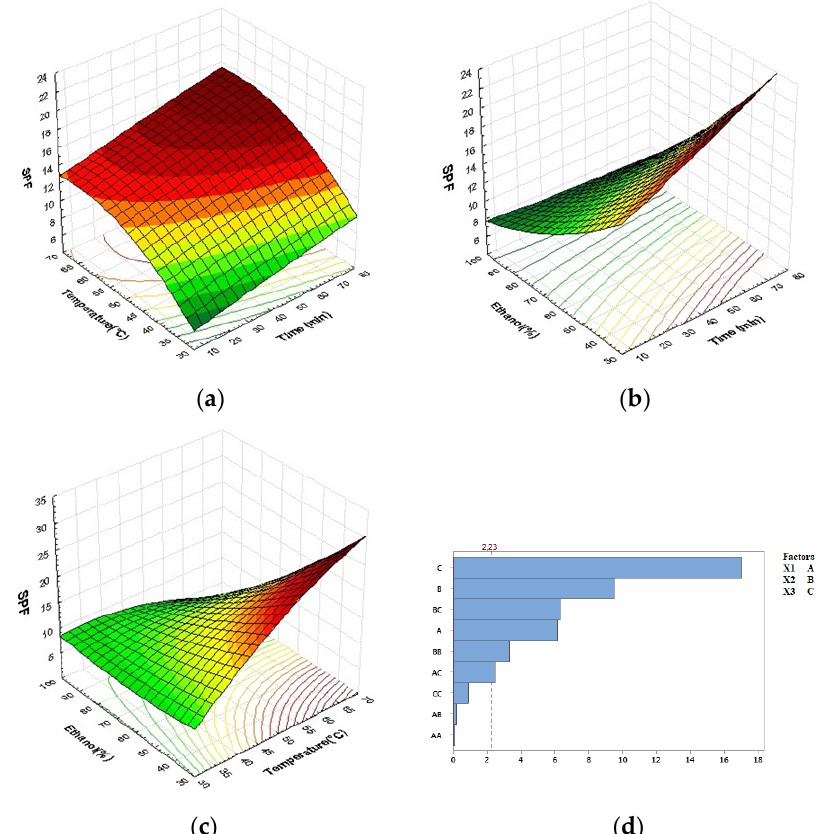
Figure 6. Response surface plots indicating combined effects of UAE variables on SPF: ( a ) time and temperature, ( b ) time and ethanol concentration, ( c ) ethanol concentration and temperature, ( d ) Pareto chart ( α = 0.05).